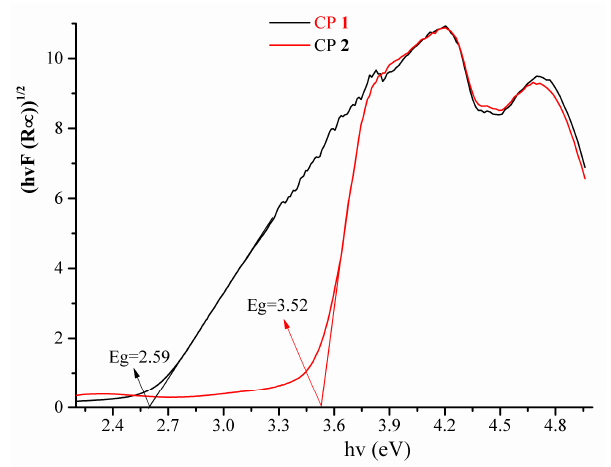
Figure 4. The Eg values for CPs 1 – 2 treated with the Kumble–Munk function.